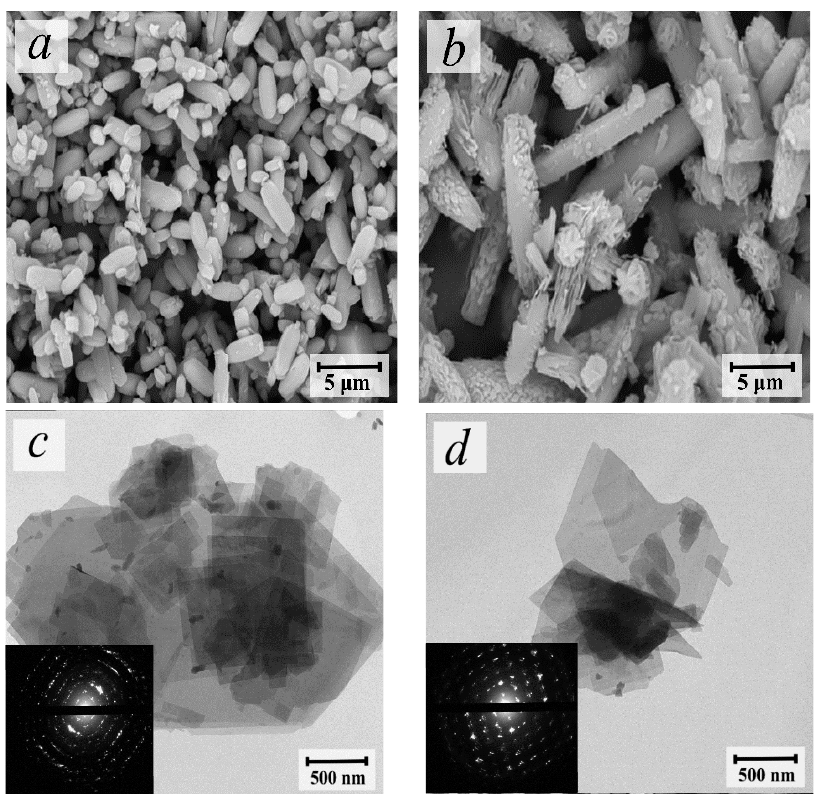
Figure 3. The micrographs of ( a , b ) SEM- and ( c , d ) TEM-synthesized zeolites: ( a , c )—Al-ZSM-12; ( b , d )—TiO 2 /Al-ZSM-12 with corresponding SAED patterns.